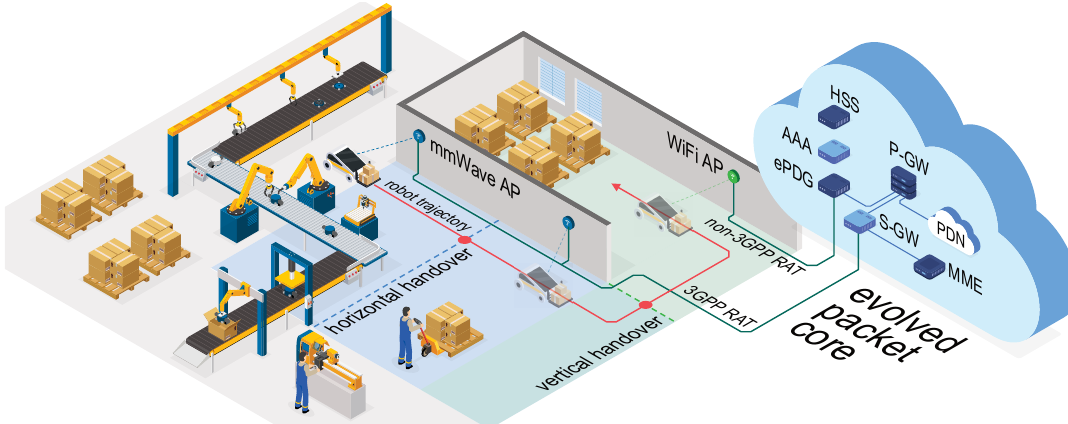
Figure 1. A conceptual figure of the principle of the location-aware handover (LHO) scheme in an industrial multi-radio